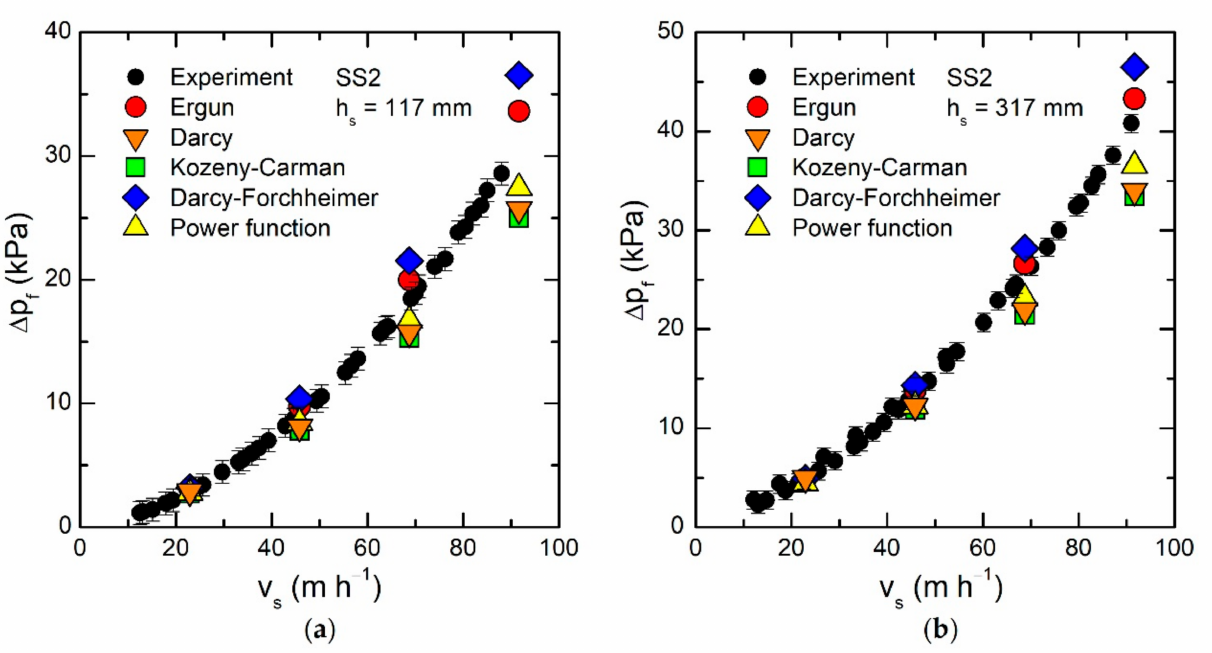
Figure 6. Filter pressure drop as a function of the superficial velocity experimentally observed and simulated using Equations (7)–(11) for the porous media (SS2) with sand height above the base plate equal to ( a ) h s = 117 mm; ( b ) h s = 317